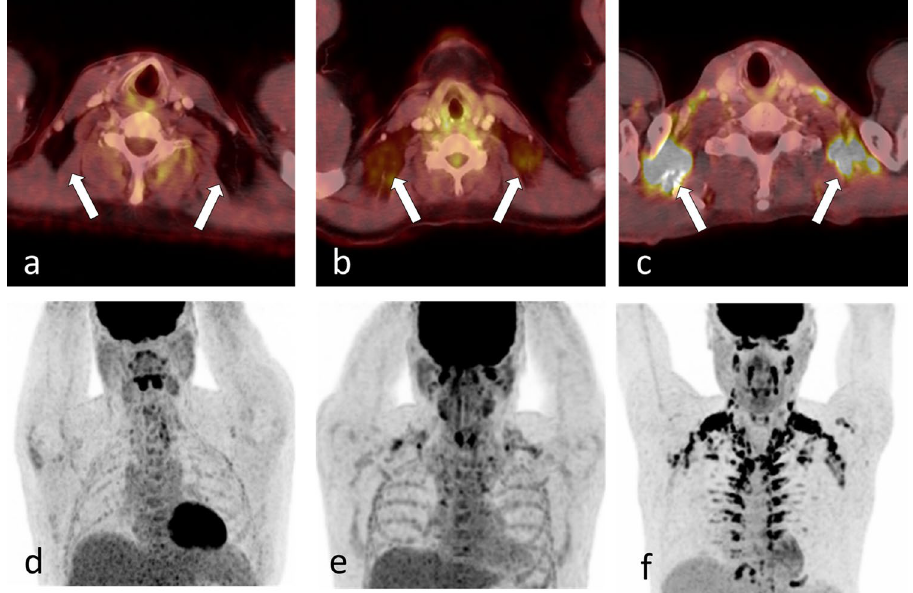
Figure 1. Categories of BAT activity. Axial fused PET/CT images ( a – c ) and maximum intensity projection of PET ( d – f ) of patient examples with no activity of brown adipose tissue (BAT, a , d ), low BAT activity ( b , e ) and high BAT activity ( c , f , see